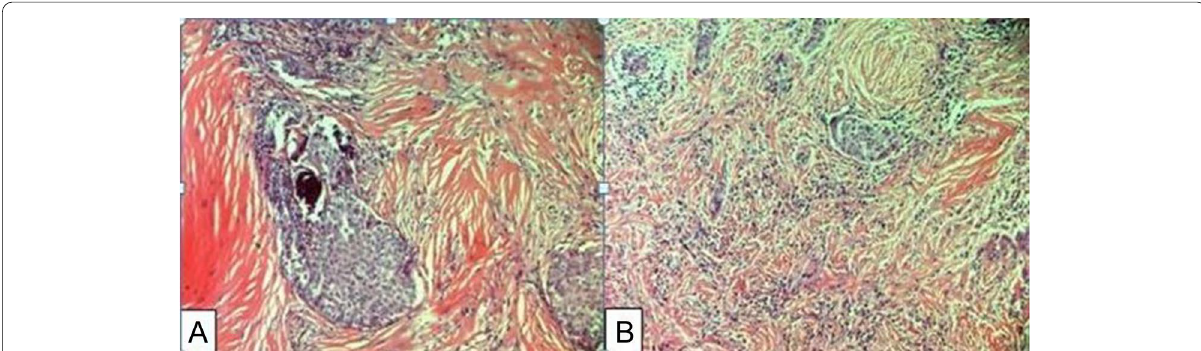
50). B Marked dense inflammatory infiltrate surrounding tumor ×